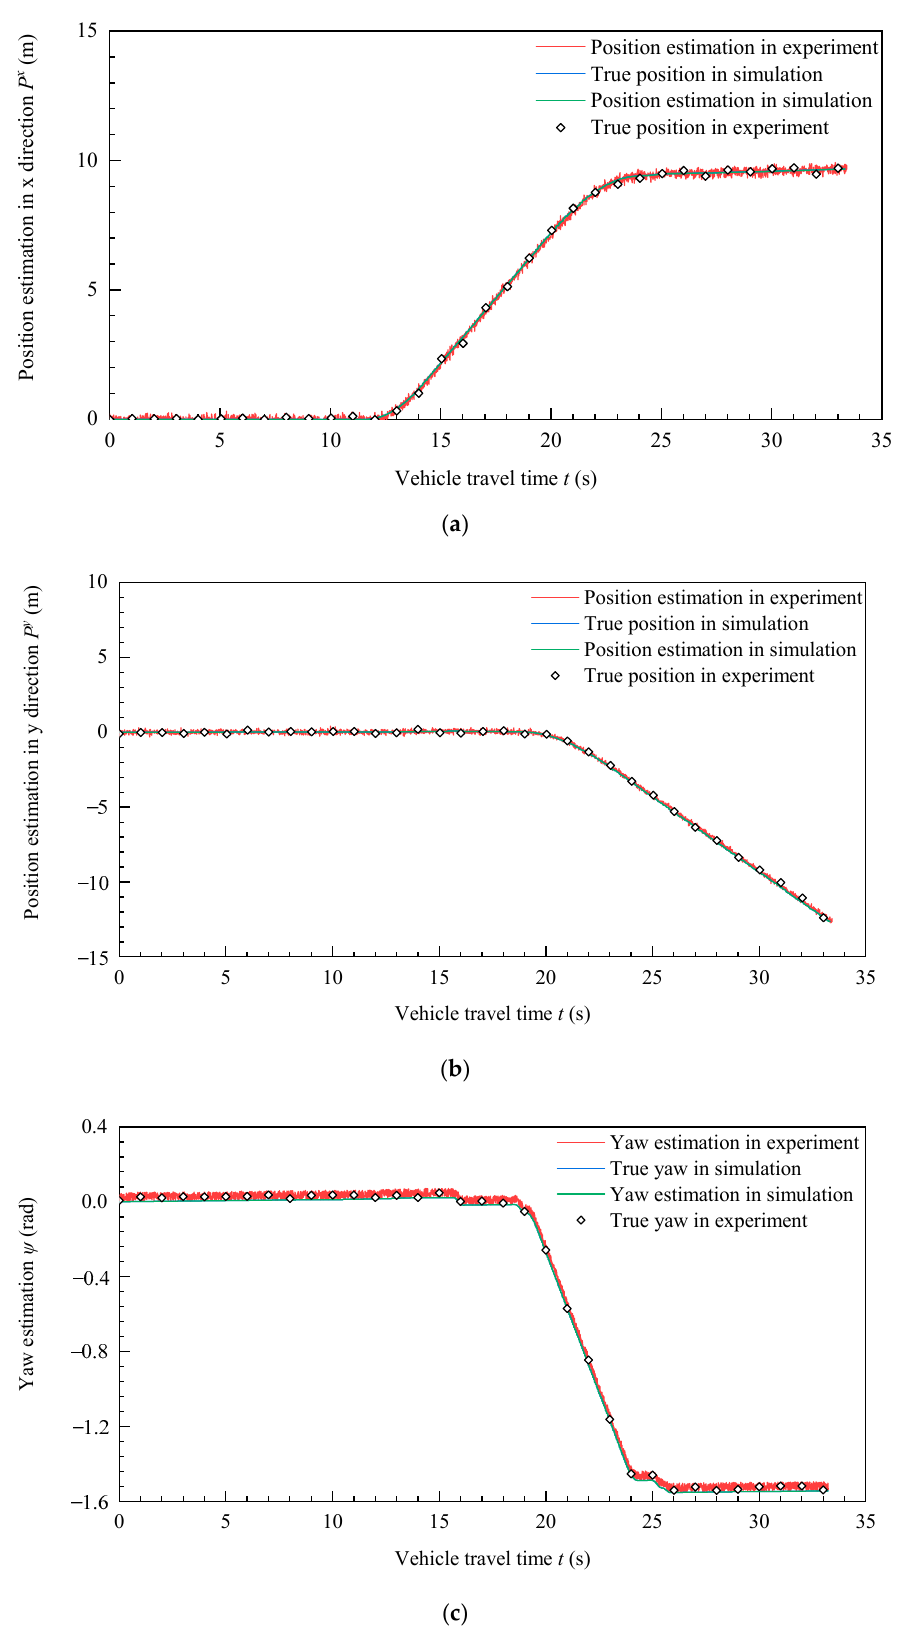
Figure 11. Position and attitude estimation of quarter turn path. ( a ) Position estimation in x direction. ( b ) Position estimation in y direction. ( c ) Yaw